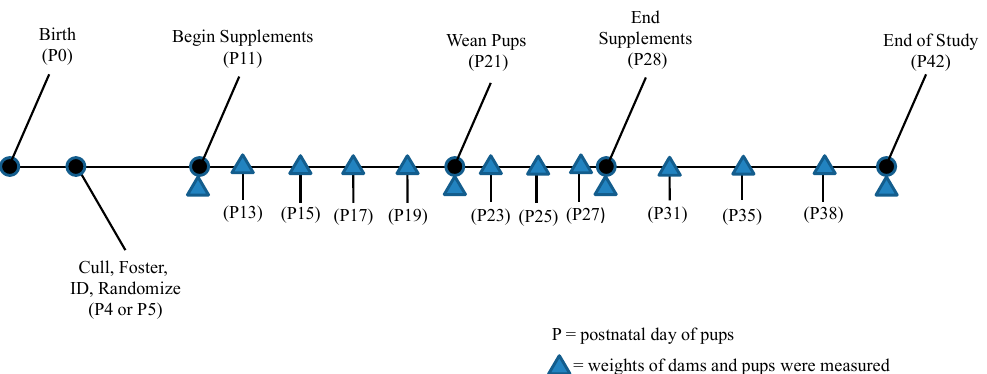
Figure 1. Experimental timeline as a function of pup age in days. Postnatal days indicated by “P” and shaded triangles indicate weight measurement in relation to experimental supplementation.